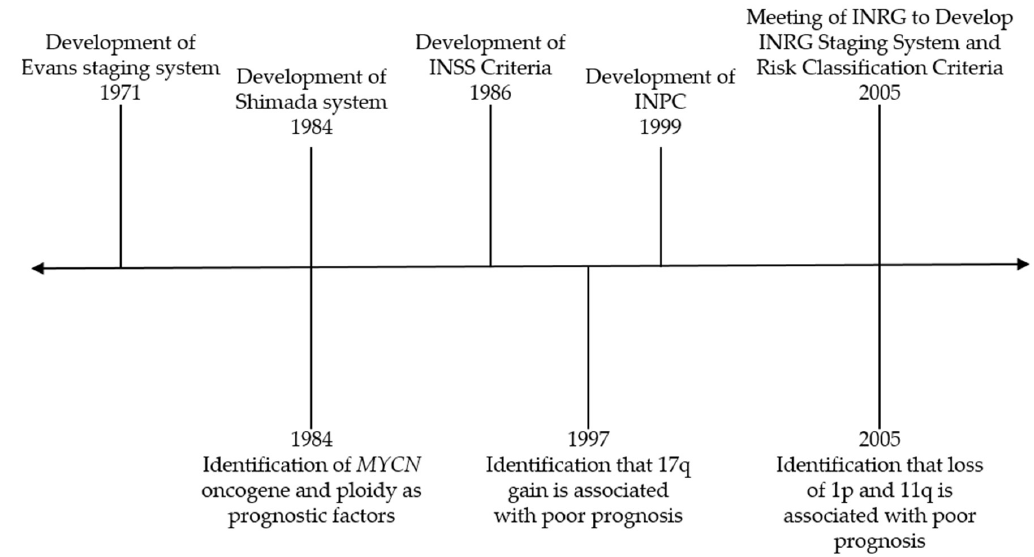
Figure 1. Timeline of major events contributing to risk classification for neuroblastoma. INSS— International Neuroblastoma Staging System; INPC—International Neuroblastoma Pathology Classification; INRG—International Neuroblastoma Risk Group.